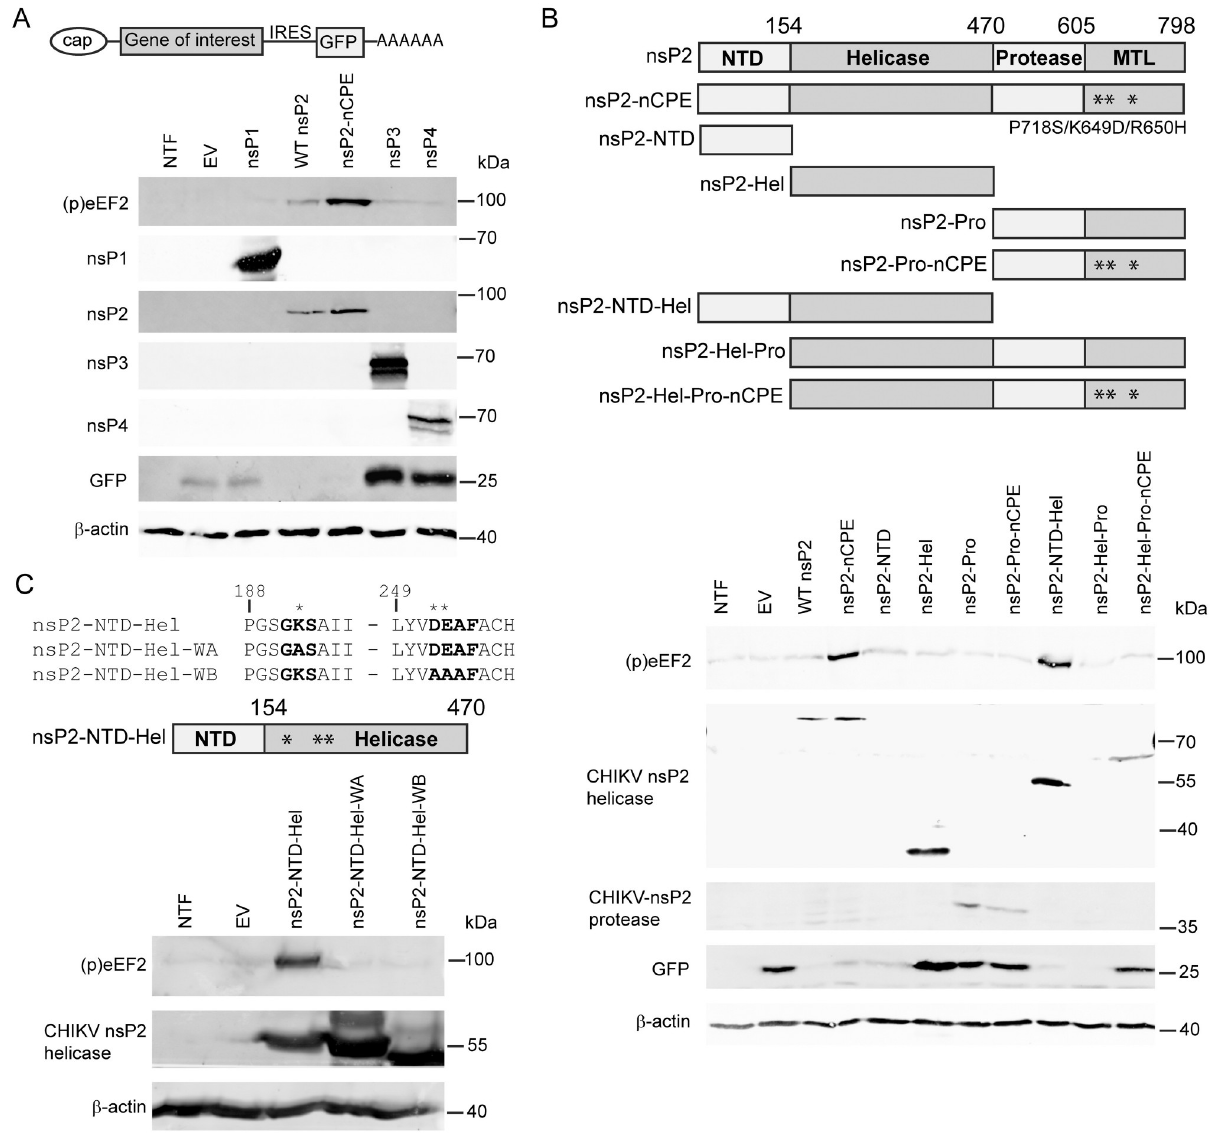
Fig 5. The helicase-associated NTPase domain of nsP2 triggers eEF2 phosphorylation. ( A ) 293T cells were transfected with the pCAGGS-IRES-GFP construct containing individual CHIKV nsPs. (p)eEF2 (T56), GFP and viral proteins, nsP1, nsP2, nsP3 and nsP4 were detected by WB. ( B ) 293T cells were transfected with the pCAGGS-IRES-GFP construct containing full-length CHIKV nsP2 or different truncations. Top: schematic view of the truncations that were used. NTD: N-terminal domain, MTL: methyl-transferase-like. Amino acid (AA) numbers are indicated in figure. � indicates mutations in the nCPE constructs. Bottom: (p)eEF2 (T56), GFP and CHIKV nsP2 helicase, CHIKV nsP2 protease and GFP were detected by WB. ( C ) 293T cells were transfected with the pCAGGS-IRES-GFP construct containing the nsP2-NTD-Hel WT sequence or 2 Walker motif mutants. Top: AA sequence surrounding Walker A (WA) and Walker B (WB) motifs (indicated in bold) and schematic view of CHIKV nsp2-NTD-Hel construct that was used. � indicates residues that were mutated in the 2 mutants. Bottom: (p)eEF2 (T56) and CHIKV nsP2 helicase were detected by WB. For all panels cells transfected with an empty vector and non-transfected cells (NTF) were included as controls. Representative blots are shown and each experiment was repeated at least 3